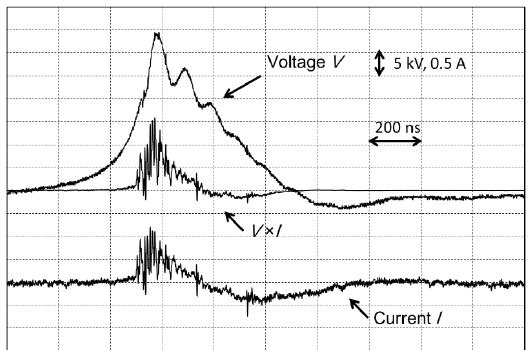
Figure 4. Waveform of voltage V , current I and instantaneous power V × I in air + NO x (300 ppm) at